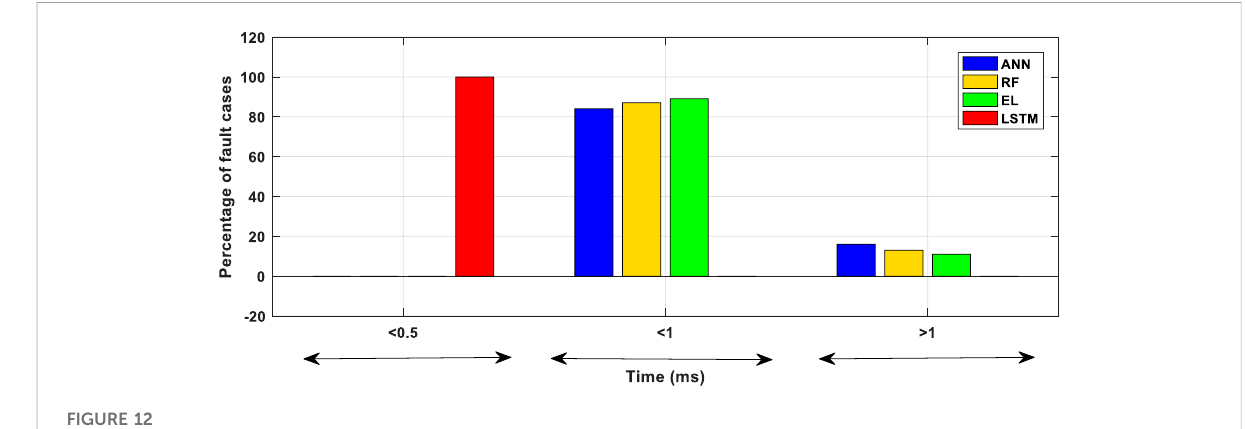
FIGURE 12 Comparison between all methods used for transmission line fault detection.